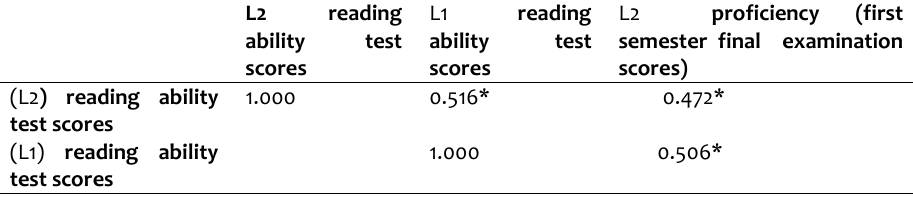
Table 2: Correlations among students’ L 1 reading ability scores and L 2 reading ability test scores as well as their first semester (L2) reading proficiency scores